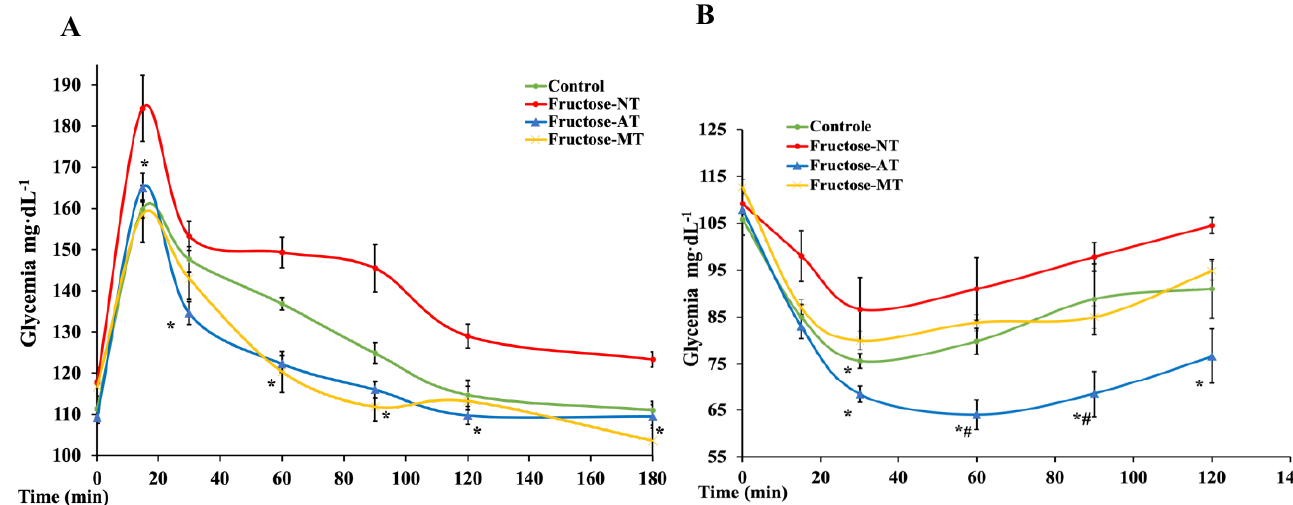
Figure 3. Tests of glucose and insulin tolerance at the end of experiment. (A ) Oral glucose tolerance. (B) Intraperitoneal insulin tolerance. *: significant differences compared to Fructose-NT . #:significant differences compared to control (p < 0,05).